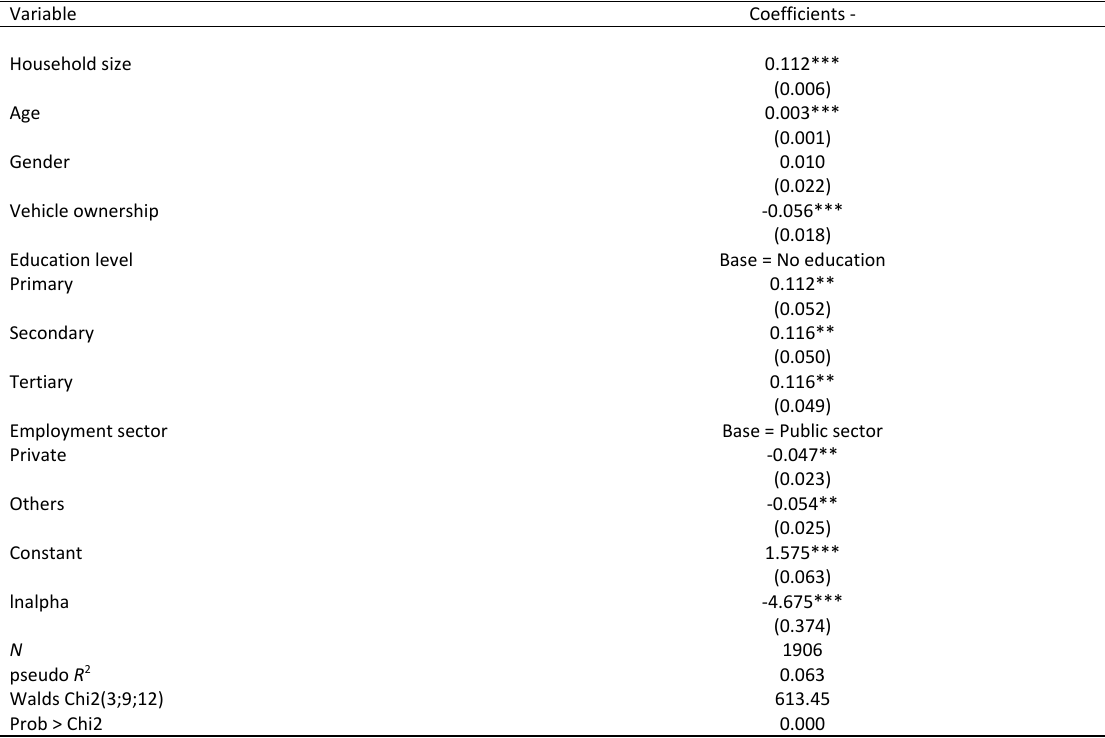
Table 4: Results for the Negative Binomial Regression.